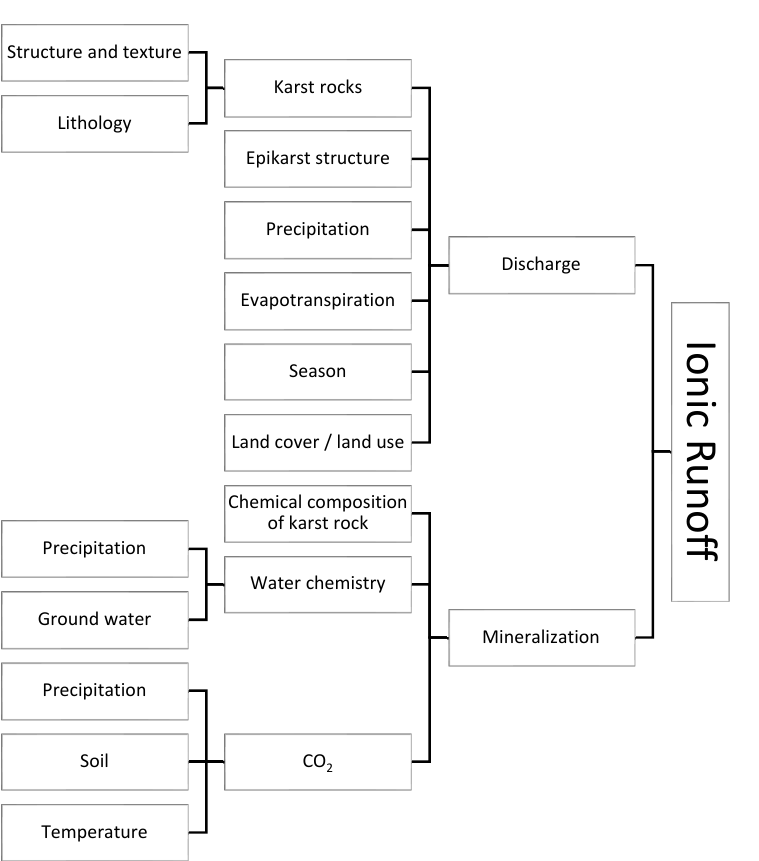
Figure 11. Relationship of air temperature and A/S (ionic runoff/area). Study areas of [5,23] and Slovak Karst, localities described in Table 2.